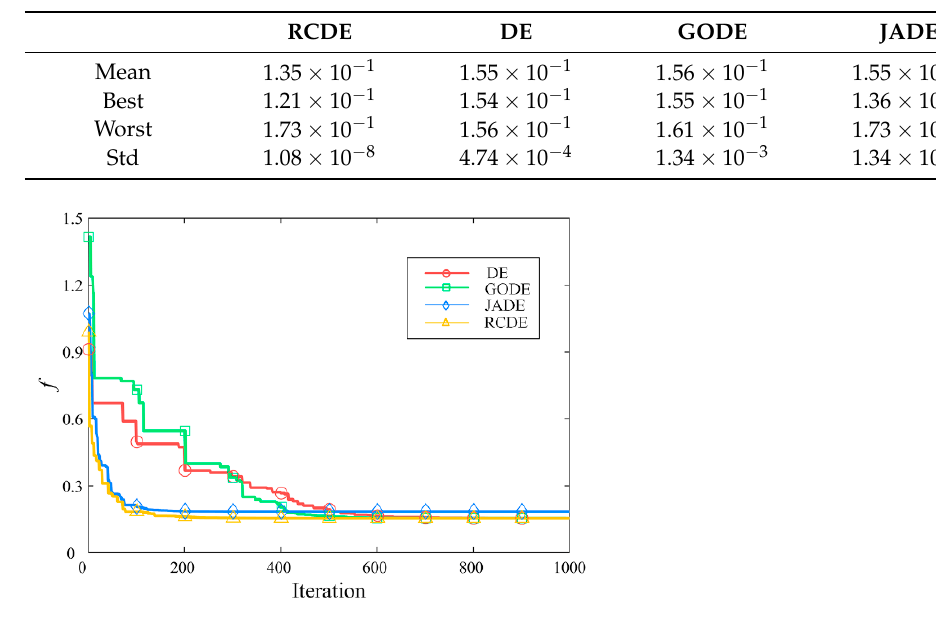
Table 7. Performance of four algorithms for solving Case 2.